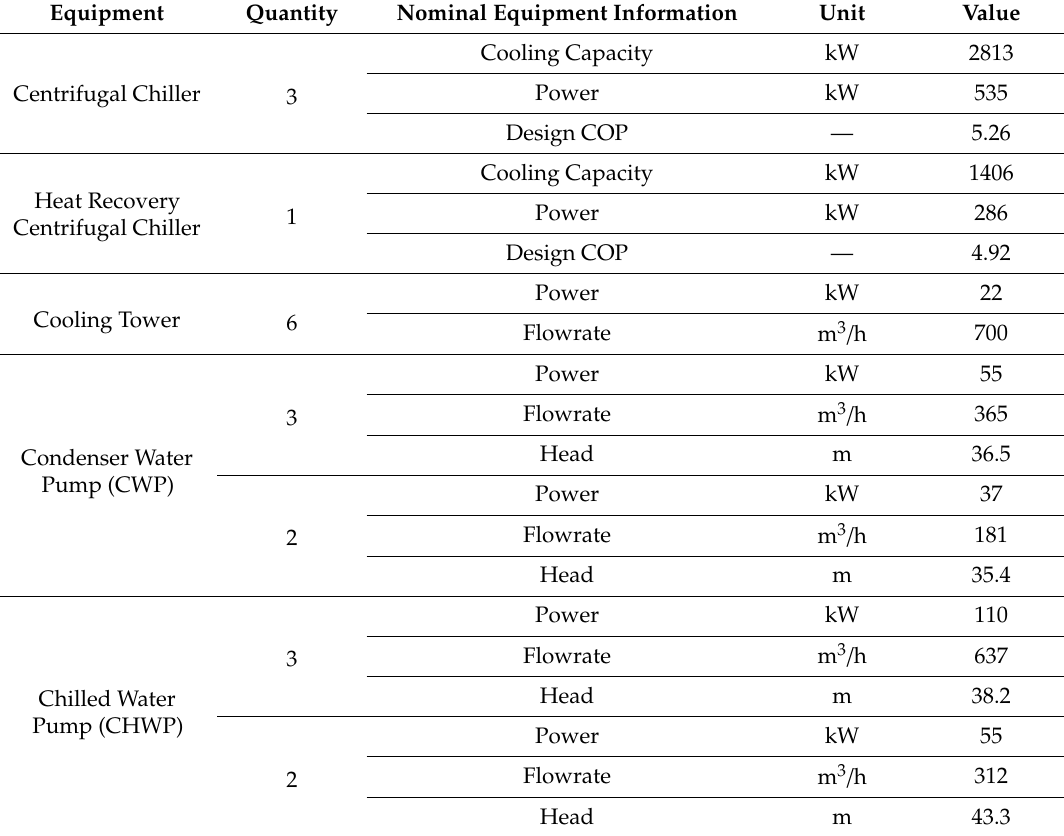
Table 2. Nominal information of the main components in the cooling